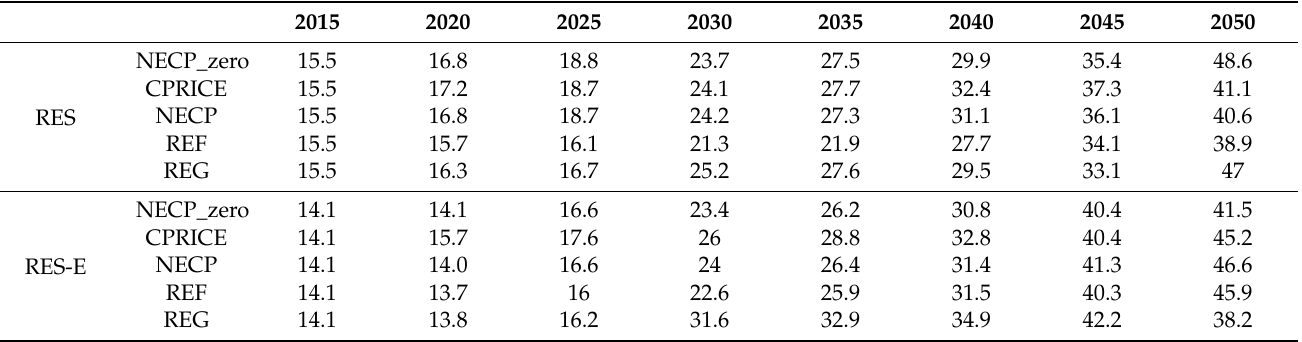
Table 9. Share of renewable energy sources in final energy consumption (RES) and electricity generation (RES-E) (%).